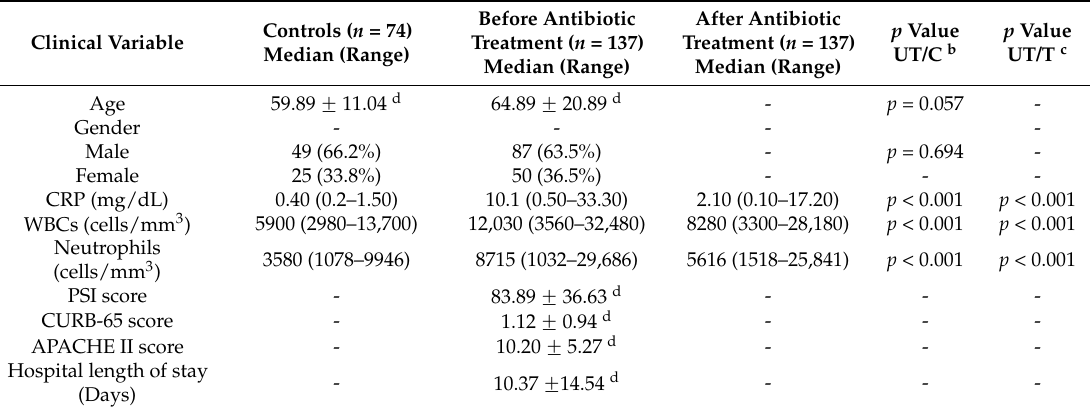
Table 1. Laboratory data of both controls and patients with community-acquired pneumonia (CAP) before and after they received treatment a .